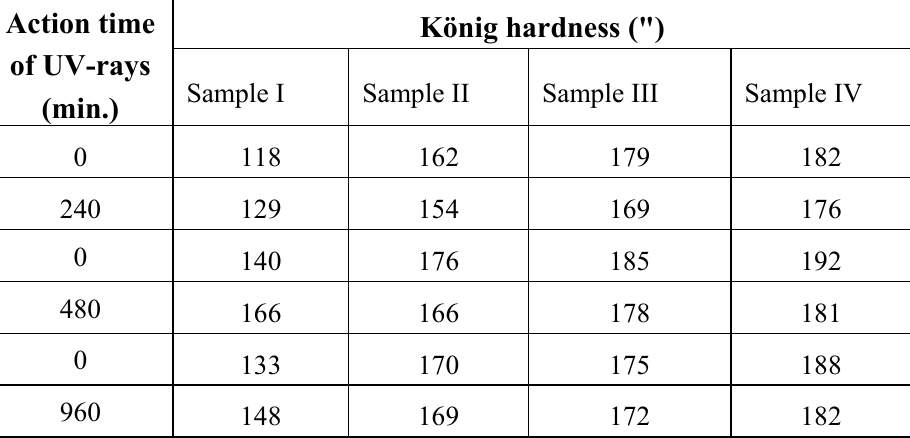
Table 3 . The hardness values of the nitrodope dry films before and after the action of UV